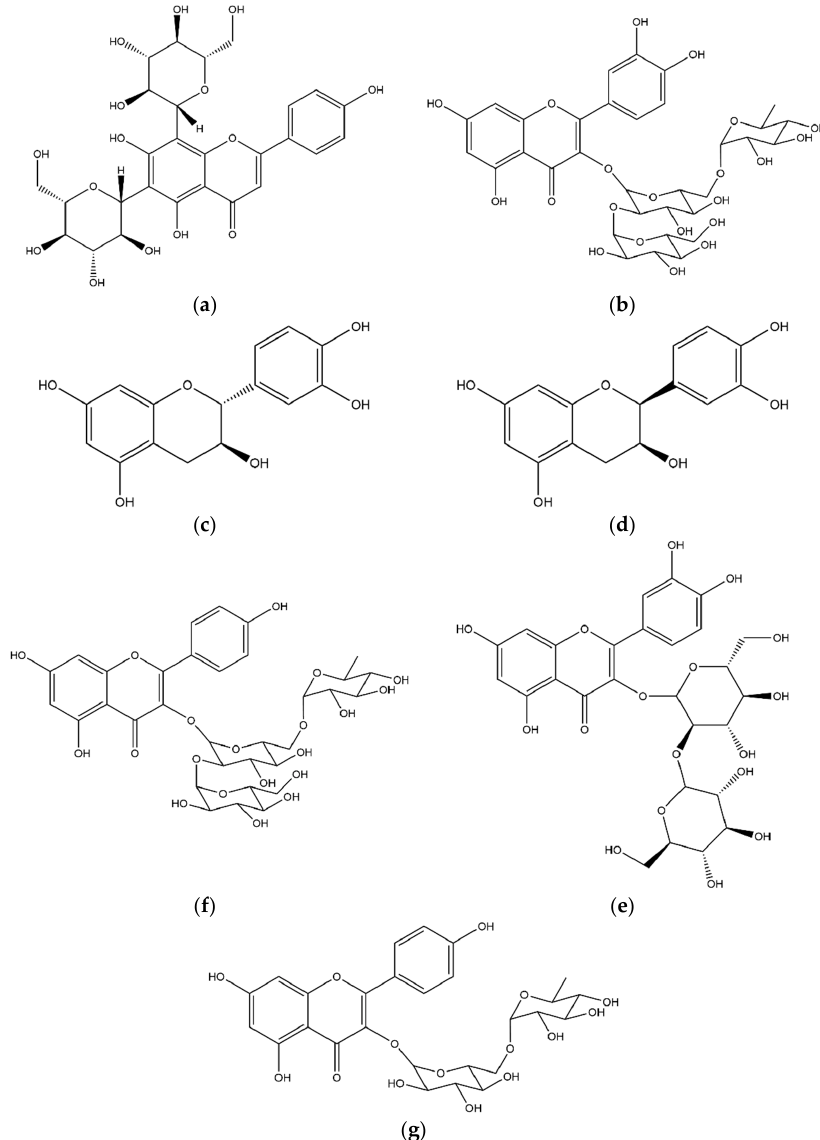
Figure 7. Structures of the main flavonoids identified in the coffee leaf extract: ( a ) apigenin 6,8-di-C-glucoside , ( b ) rutin glicoside , ( c ) (+)catechin, ( d ) (+)epicatechin, ( e ) quercetin sophoroside, ( f ) kaempferol triglycoside, ( g ) kaempferol rhamnoglucoside. Two compounds with the same [M − H] − ion at m / z 289 were eluted at Rt 5.28 min and 10.38 min. The two compounds show the same fragmentation pattern in both MS 2 and MS 3 fragmentation steps. The fragmentation was compatible with the one obtained for the catechin and epicatechin standards, and was compared with databases and literature [34]. Compounds 20a and 20b were identified as catechin/epicatechin (Figure 7c,d). Compound 30 showed a Rt 20.70 min and a base peak ion at m / z 625; the compound was identified as quercetin sophoroside (Figure 7e) based on the relative abundances and the values of the neutral losses in MS 2 and MS 3 spectra. In MS 2 , four main product ions